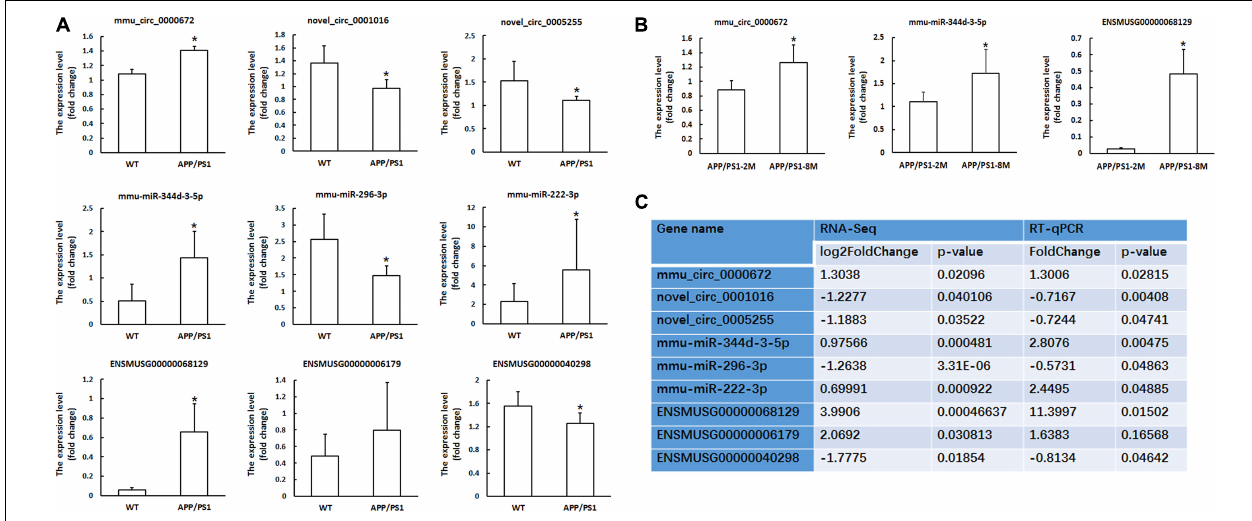
FIGURE 2 | Validation of circRNA, miRNA and mRNAs expression by qPCR. (A) The expression levels of candidate circRNAs, miRNAs and mRNAs for validation by qPCR in hippocampal tissues of 8-month-old APP/PS1 mice and WT mice. (B) The expression levels of candidate circRNAs, miRNAs and mRNAs for validation by qPCR in hippocampal tissues of 8-month-old APP/PS1 mice and 2-month-old APP/PS1 mice. CircRNA and mRNA expression was quantified relative to Gapdh expression level by using the comparative cycle threshold ( (cid:49) CT) method. MiRNA expression was quantified relative to U6 expression level by using the comparative cycle threshold ( (cid:49) CT) method. Data are presented as means ± SD ( n = 6; * p < 0.05). (C) The comparison information of the RNA-Seq and qRT-PCR data of 8-month-old APP/PS1 mice vs. WT mice.